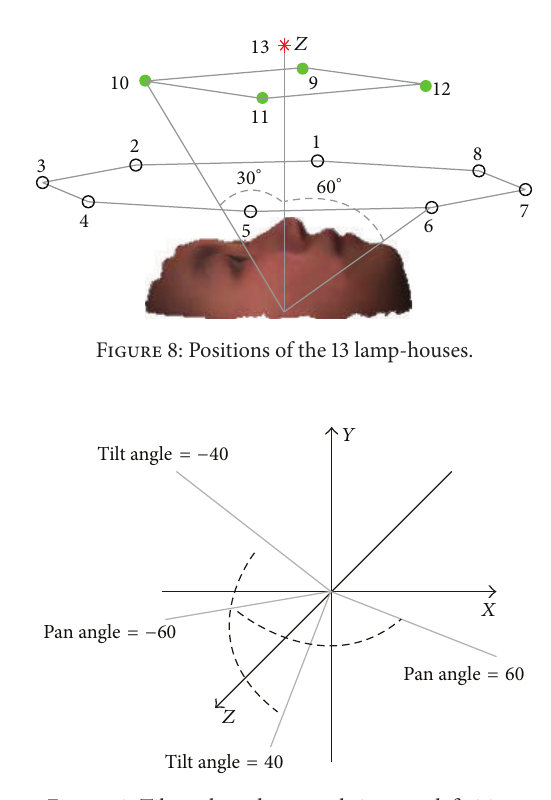
Figure 9: Tilt angle and pan angle in pose